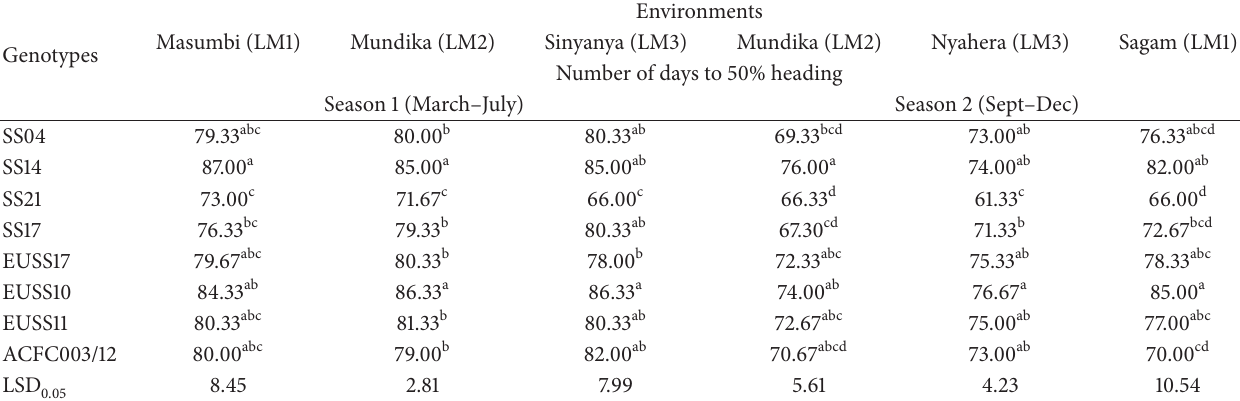
Table 2: Influence of environment on maturity (days to 50% heading) of sweet sorghum genotypes.